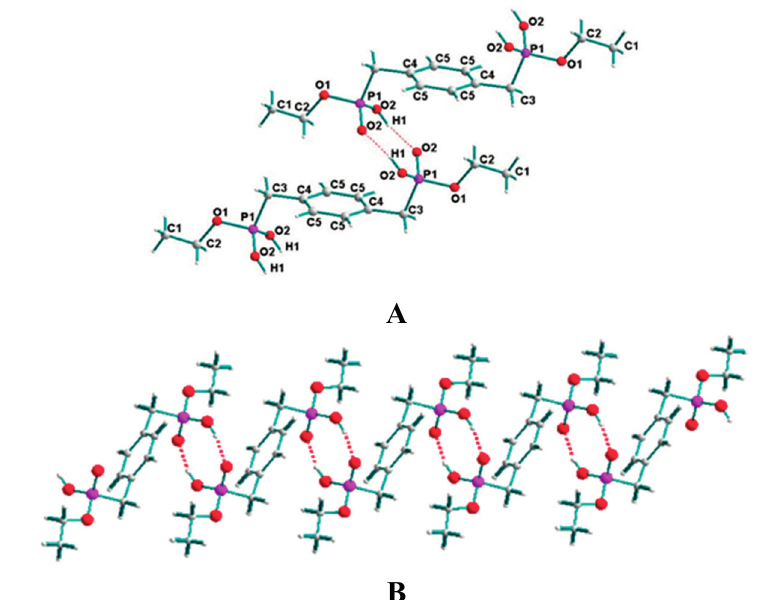
Figure 1. ( A ) Molecular structure of 1 with atomic numbering and ( B ) the molecular arrangement by the hydrogen bonds between adjacent H 2 [BBPEH 2 ]